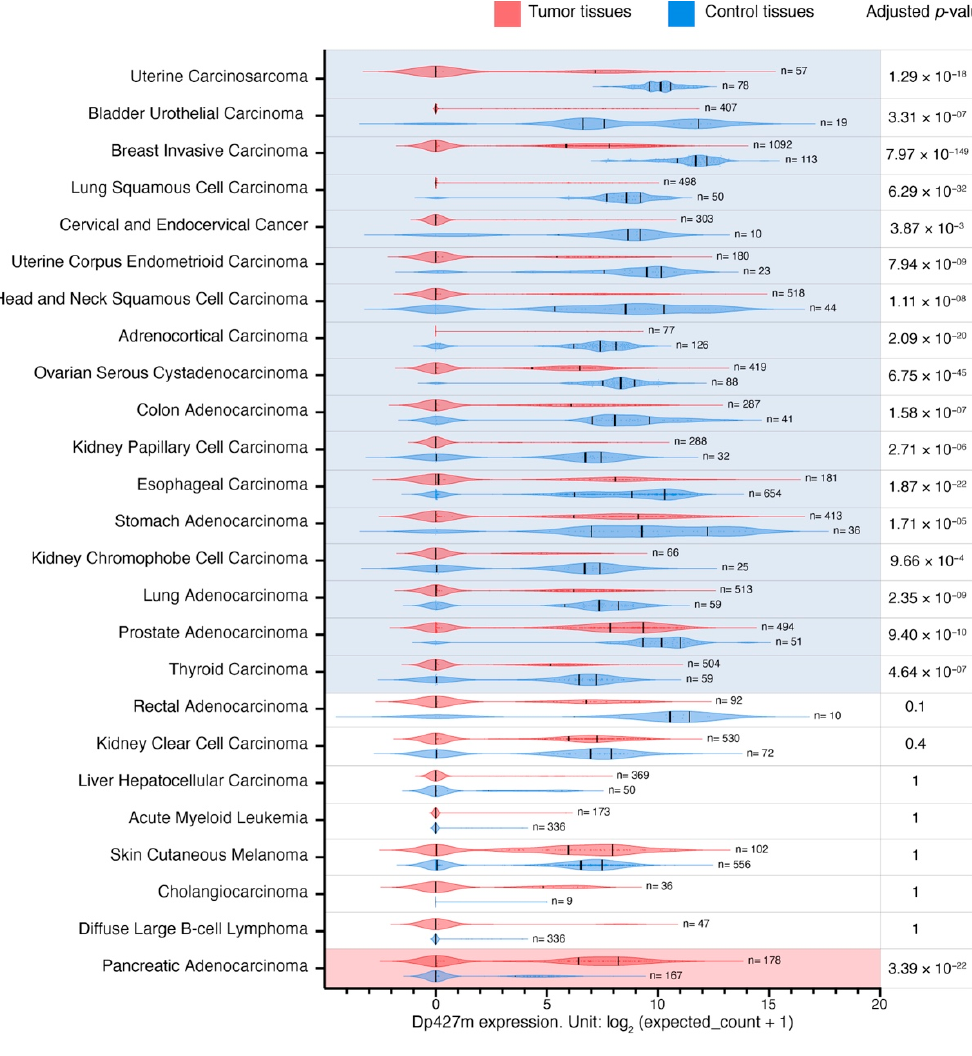
Figure 3. Dp427m transcript expression level in primary tumors and corresponding control tissues. Red and blue violin plots represent tumor and control tissues, respectively. Vertical black lines represent the median and quartiles. Comparisons (n = 17) with a statistically significant downregulation of Dp427m expression in tumor samples compared to controls are highlighted in blue, and one comparison with a statistically significant upregulation of Dp427m expression in tumor samples compared to controls is highlighted in red ( p < 0.05, Supplementary Table S6). The p -Values were calculated using the UCSC Xena Browser using a two-tailed Welch’s t test and adjusted for multiple testing using the Bonferroni correction.